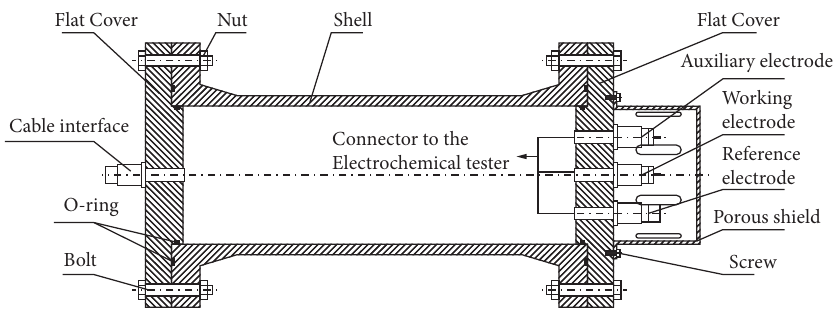
Figure 7: Shell structure of the watertight electronic cabin (figure from